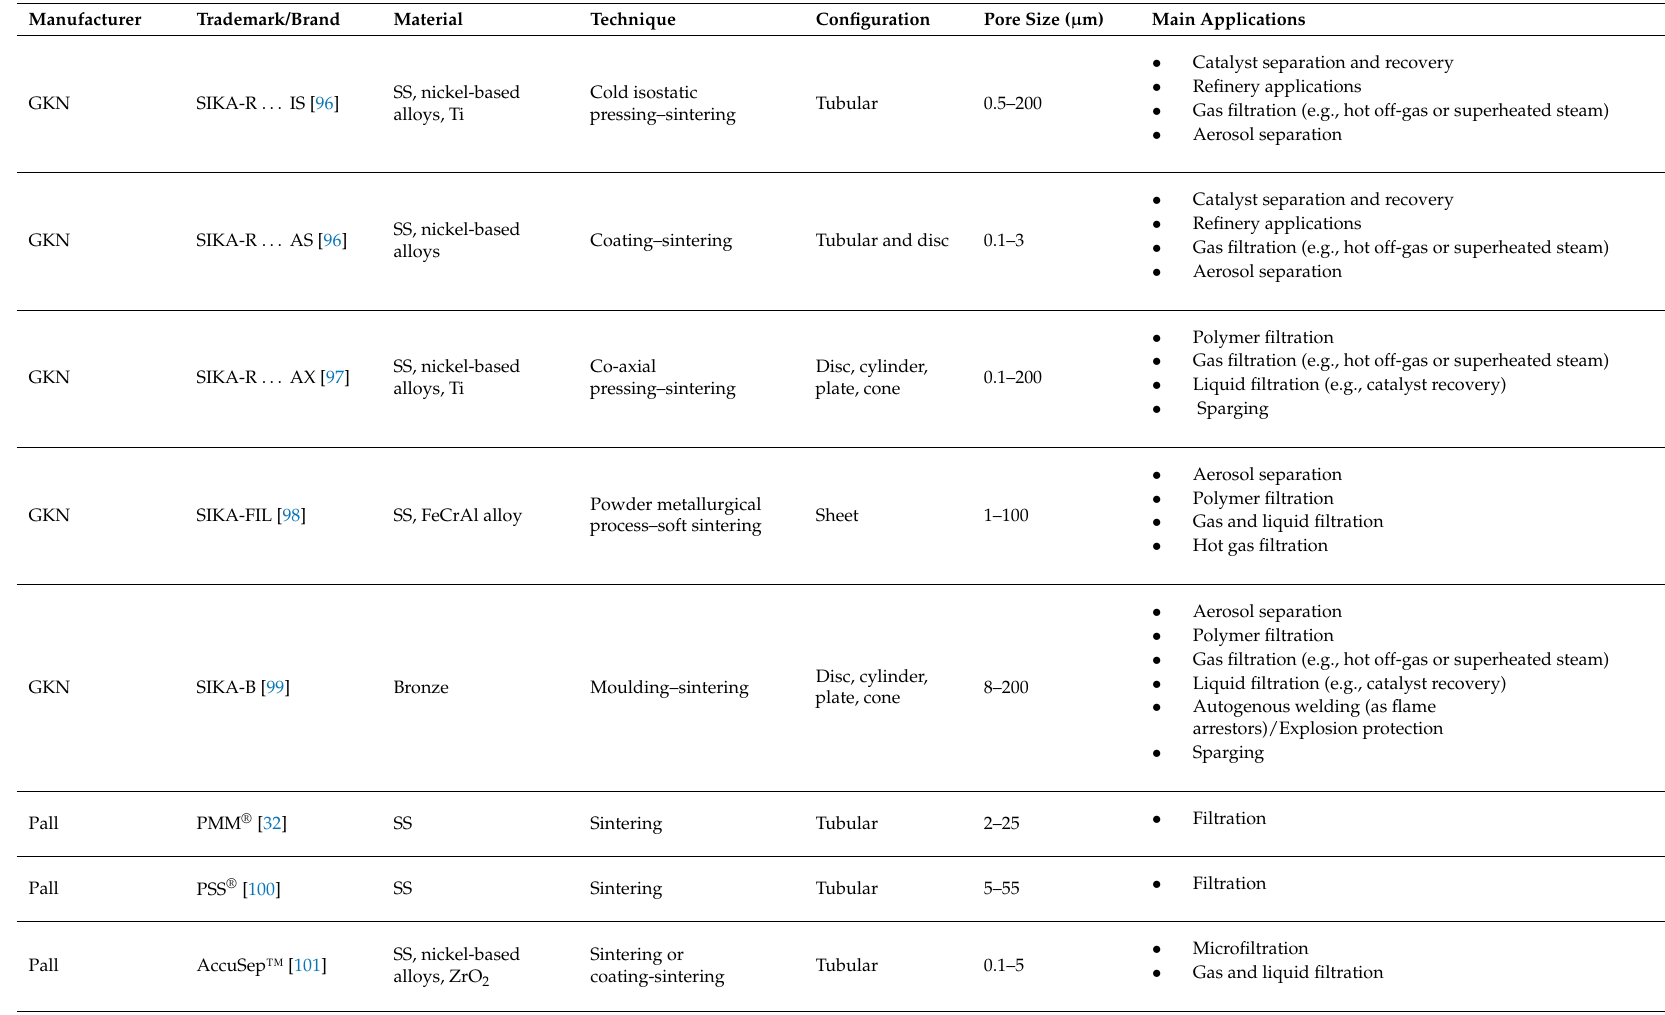
Table 2. Summary of commercial porous metal